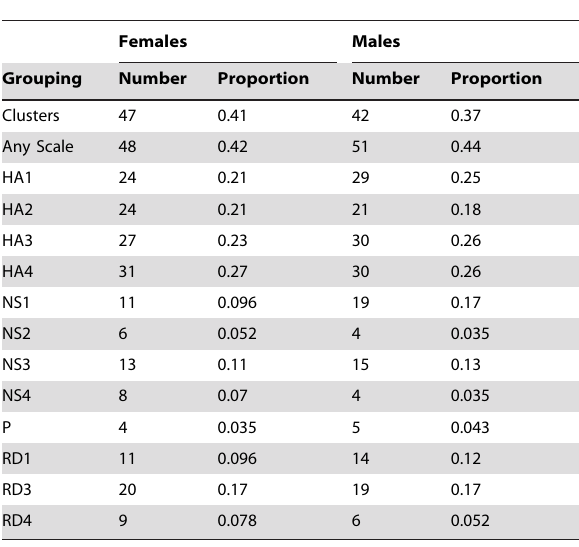
Table 1. Number and proportion of variables significantly associated with clusters, any scale, and each individual scale, after correction for multiple